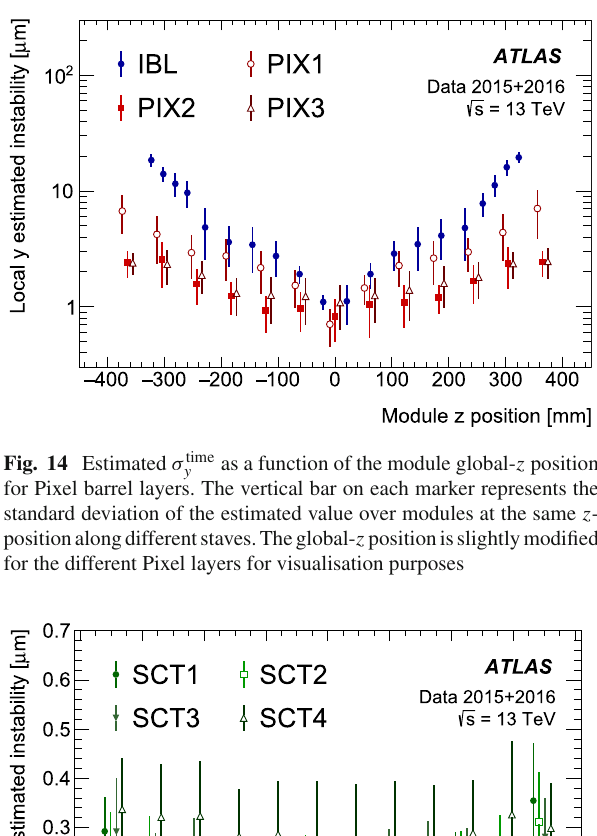
module and σ r is the standard deviation of the residu- x , y als, is computed assuming that the residual distribution is of the dis- approximately Gaussian. The dispersion σ (cid:11) r x , y (cid:12) tribution in (cid:11) r x , y (cid:12) obtained from all LHC fills is an